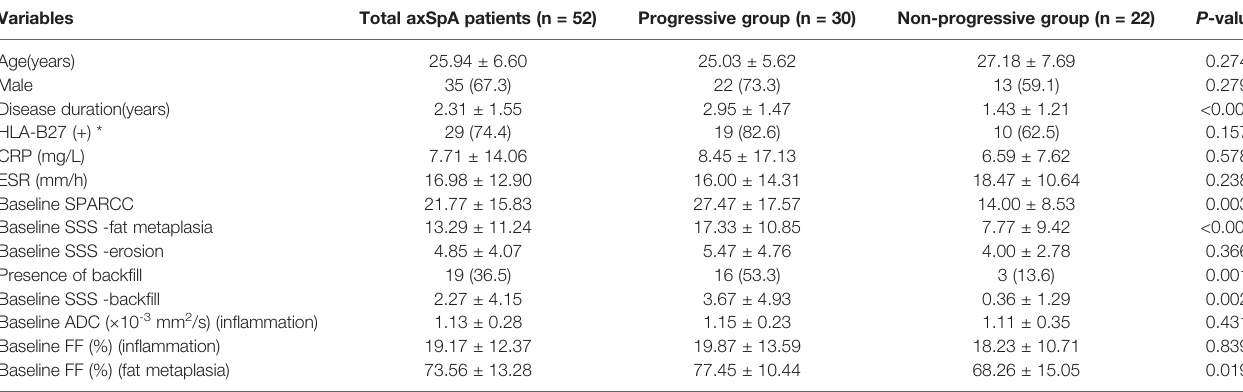
axSpA,axialspondyloarthritis;HLA ‐ B27,humanleukocyteantigen-B27;CRP,C ‐ reactiveprotein;ESR,serumerythrocytesedimentrate;SPARCC,SpondylarthritisResearchConsortium of Canada; SSS, sacroiliac joint Structural scoring method; ADC, apparent diffusion coef fi cient; FF, fat fraction. Values given as mean ± SD or n (%). *Available in 39 patients.